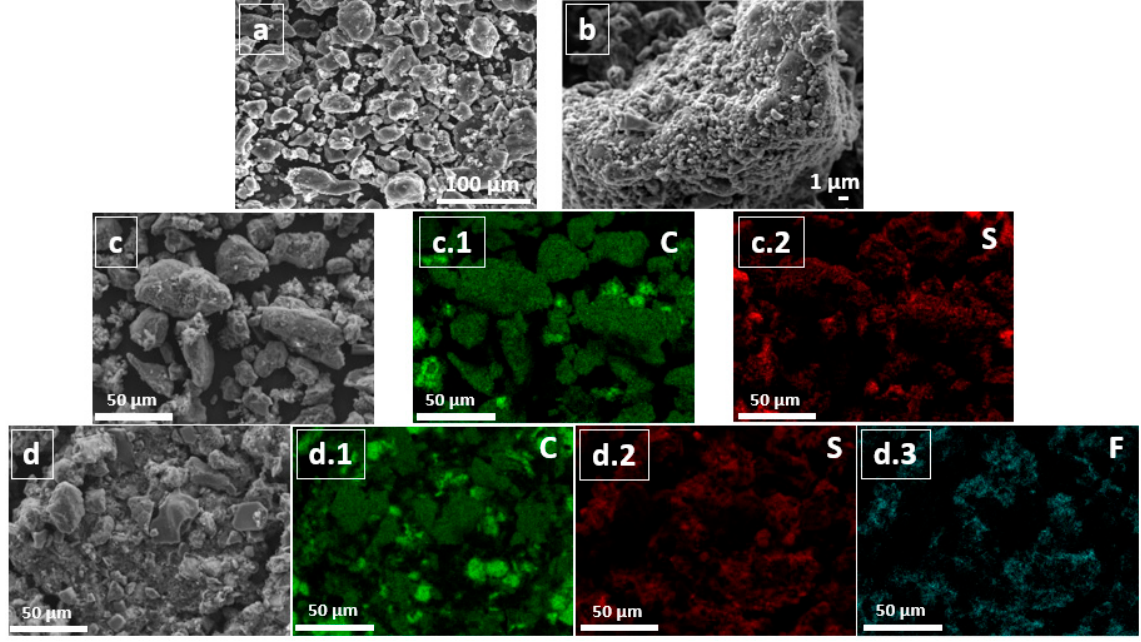
Figure 5. SEM images of ( a,b ) ASC, ( c ) ASC/S composite with C ( c.1 ) and S ( c.2 ) elemental mapping, and ( d ) ASC/S electrode with C ( d.1 ), S ( d.2 ), and F ( d.3 ) elemental mapping.